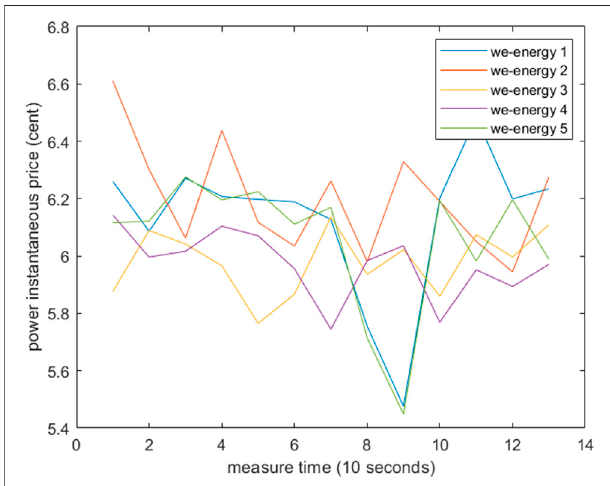
FIGURE 2 | Heat instantaneous price